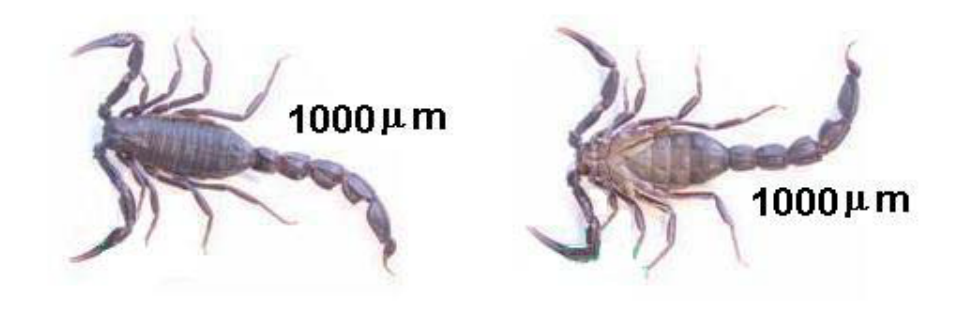
Figure 7. Androctonus bicolor collected in the Riyadh region.